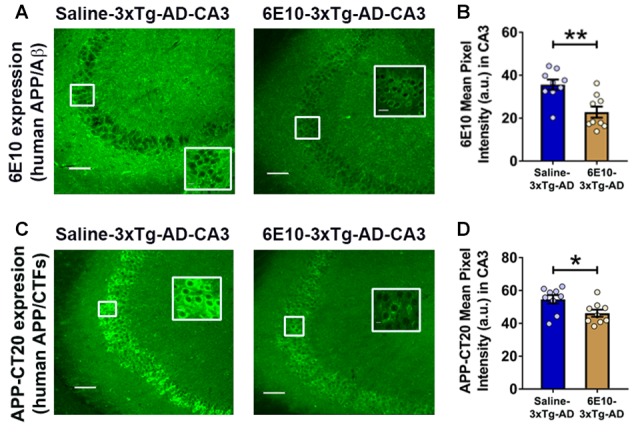
Reduction in intraneuronal human APP/Aβ expression by passive immunization with anti-human APP/Aβ antibody, 6E10, in the hippocampal CA3 region of 3-week-old 3xTg-AD mice. (A) Representative photomicrographs illustrating reduction in 6E10 (human APP/Aβ) intraneuronal immunoreactivity in the hippocampal CA3 region of young 3xTg-AD mice after passive immunization with 6E10. (B) Densitometric quantification of the immunohistochemistry data with 6E10 expression. (C) Representative photomicrographs showing decrease in APP-CT20 (human APP/CTFs) intraneuronal expression in the hippocampal CA3 region of young 3xTg-AD mice after passive immunization with 6E10. (D) Densitometric quantification of the immunohistochemistry data with APP-CT20 expression. The data are shown as mean ± SEM from Saline-3xTg-AD (n = 9) and 6E10–3xTg-AD (n = 9), and compared using Student’s t-test. Insets show the designated areas at higher magnification. Scale bar = 100 μm. *p < 0.05, **p < 0.01.